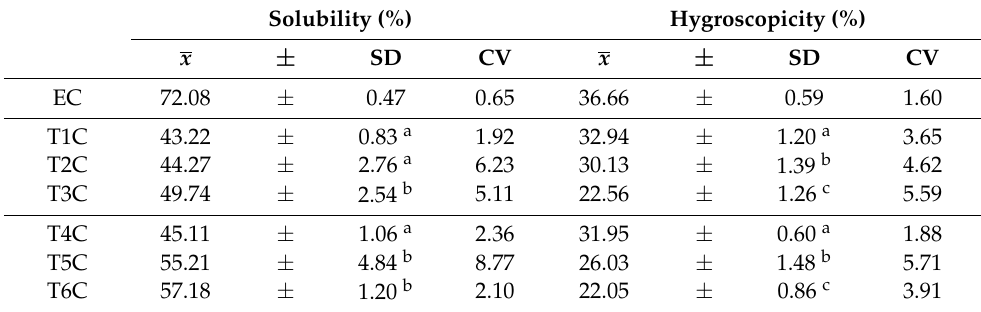
Table 3. Solubility and hygroscopicity of erythrocytes and encapsulates.